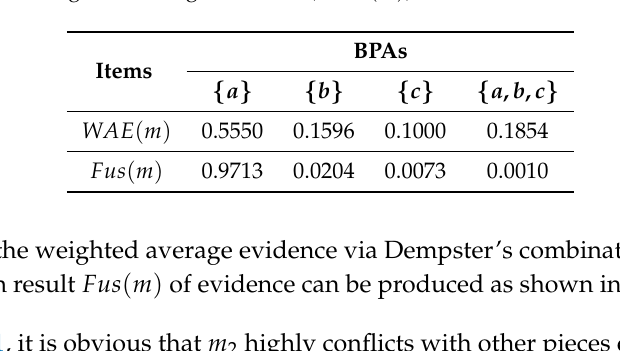
Table 3. The weighted average evidence ( WAE ( m ) ) and final fusion result ( Fus ( m ) ) .